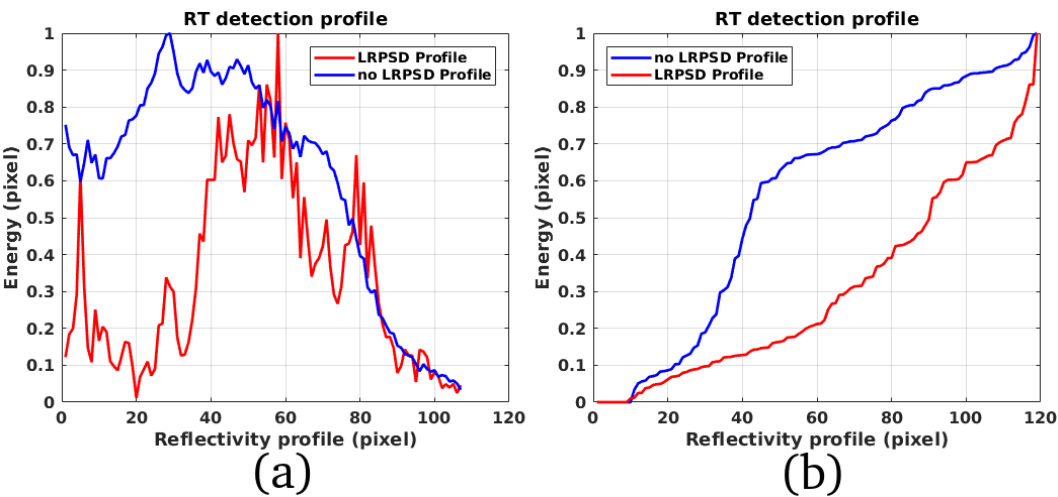
Figure 21. ( a ): Reflectivity profiles. ( b ): Receiving operating characteristic (ROC)